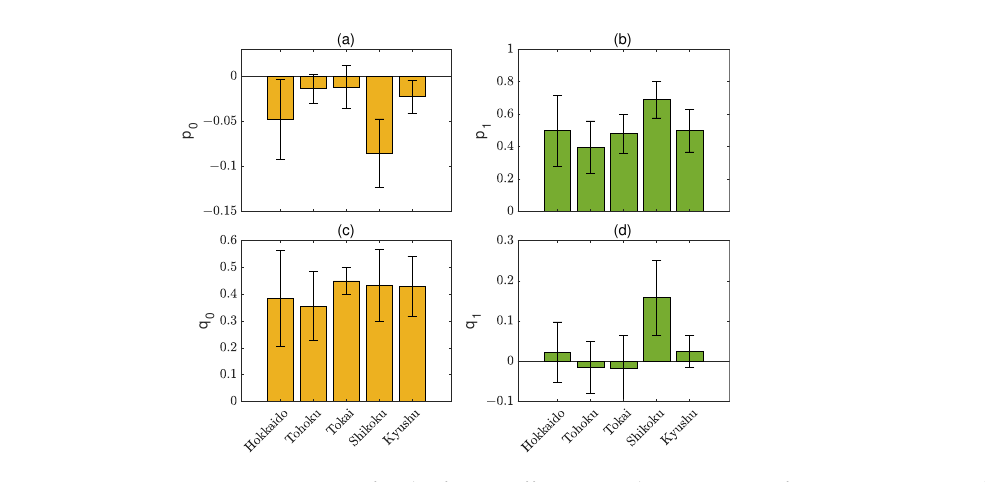
Figure 7. Averages for the four coefficients in the NDVI transformation equation ( p 0 , p 1 , q 0 , and q 1 ) for the five test sites. ( a – d ) correspond to p 0 , p 1 , q 0 , and q 1 , respectively. The error bars correspond to the standard deviation.